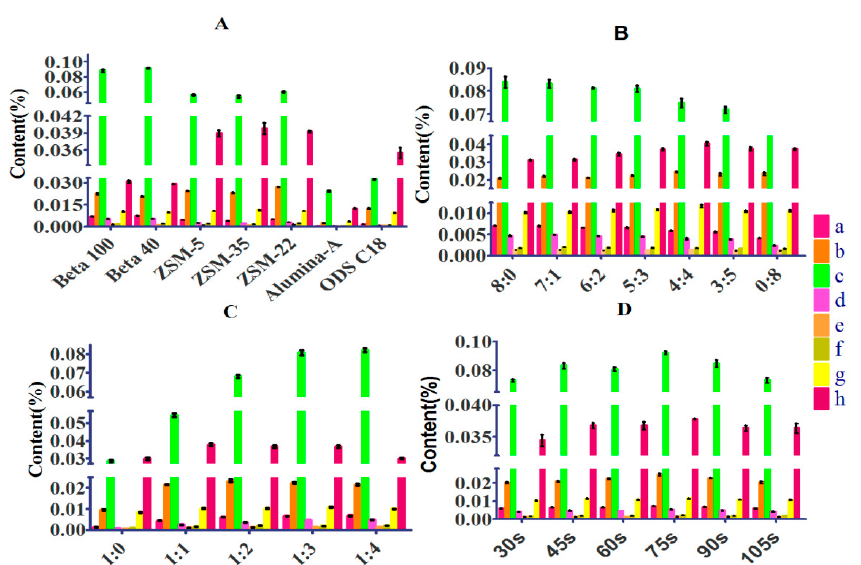
Figure 2. Effects of parameters on efficiency of 8 contents: a, protocatechuic acid; b, p -hydroxybenzoic acid; c, agnuside; d, 10- O -vanilloylaucubin; e, vanillin; f, luteolin; g, 5,3 ′ -Dihydroxy-6,7,4 ′ -trimethoxyflavanone; h, casticin. ( A ) Types of the sorbent. ( B ) Ratios of Beta to ZSM-22. ( C ) Ratios of sample to sorbent. ( D ) Grinding time.